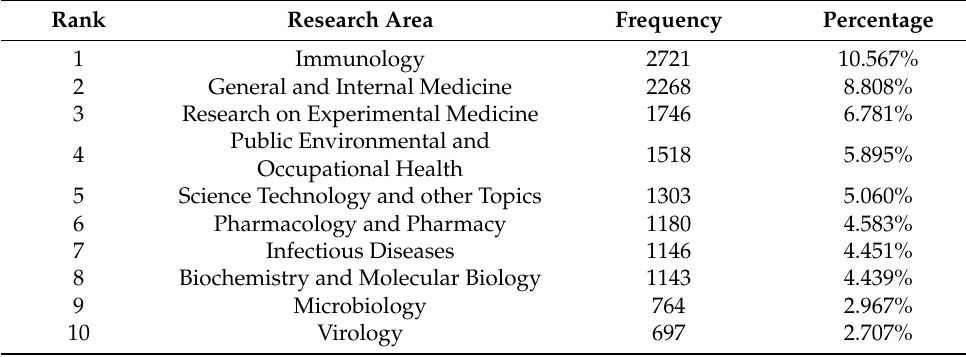
Table 6. The top 10 research areas of publications on COVID-19 vaccines.